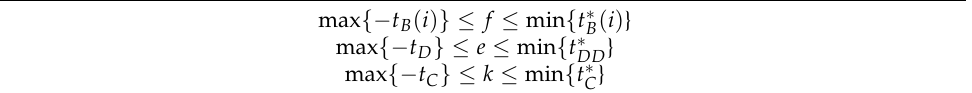
Table 4. Bounds on Scaling Parameters in Admissible Transformations For the Standard Binary Tree for Ordered Processes For Measure Parameters to be